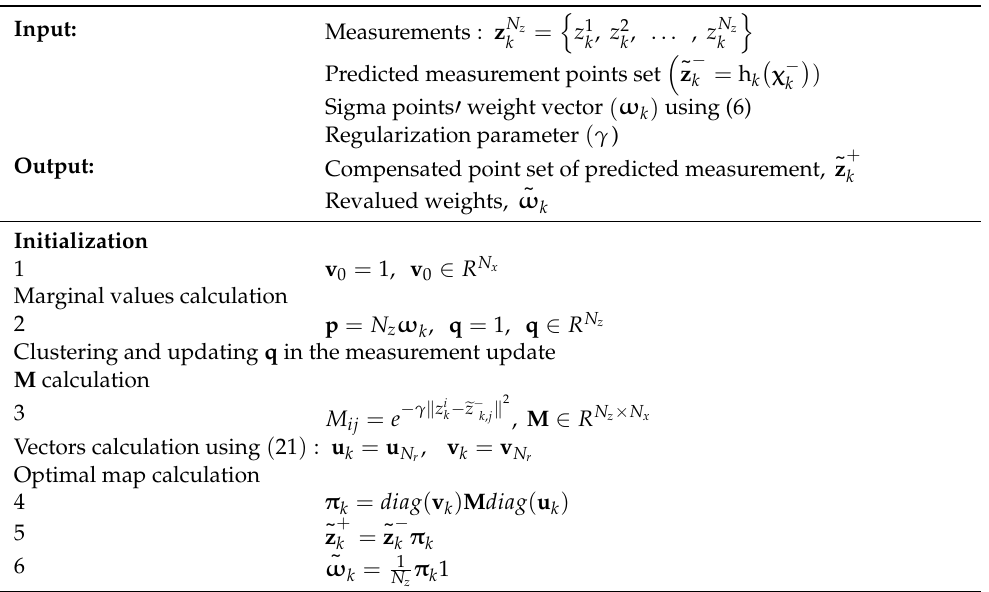
Table 1. Pseudocode of the regularized optimal